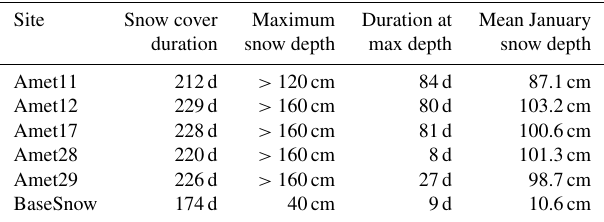
Table 2. Snow cover duration, maximum snow depth, duration at maximum depth and mean January snow depth for each SCLT site for 2018–2019 using the change-point method with raw lux